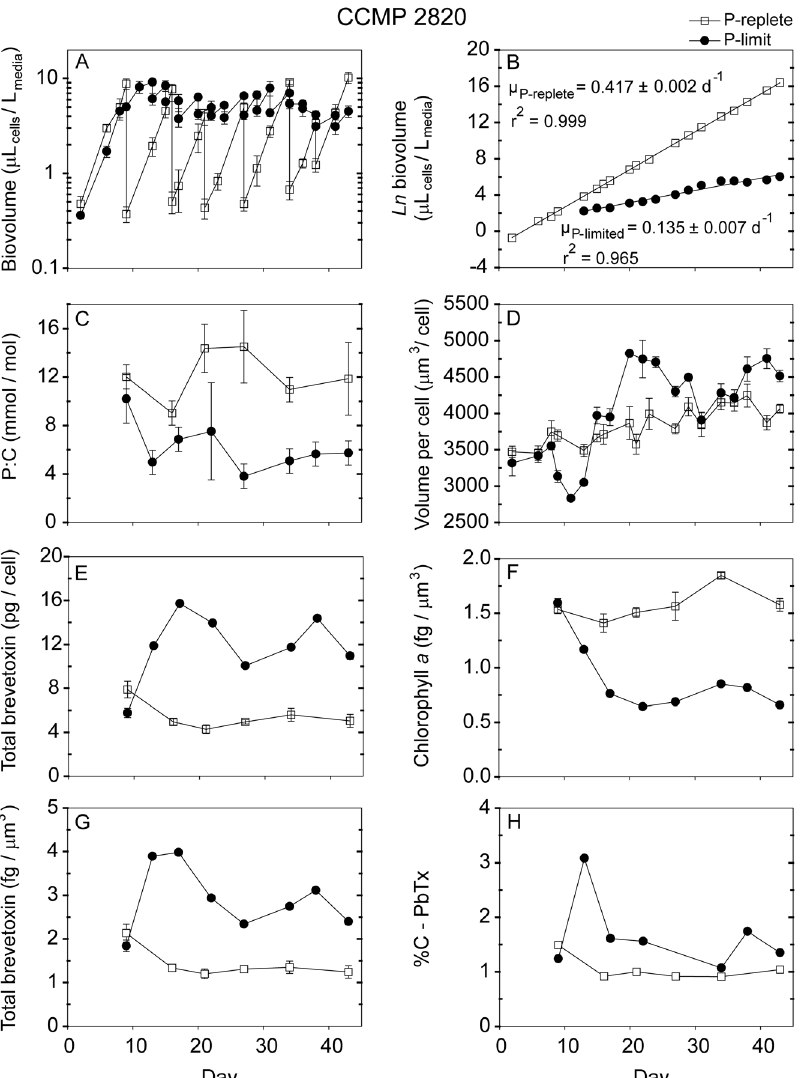
Figure 4. Time dependent results from semi-continuous batch cultures a Kareniabrevis strain CCMP 2820 grown at nutrient-replete rates in high-P media (open squares) and grown into P-limitation in low-P media (filled circles). (A) Biovolume ( m L cells /L media ) plotted on a log scale vs. time, (B) Natural logarithm (ln) biovolume vs. time, correcting for culture dilution [39], (C) Cellular P:C ratios (mmol/mol), (D) Mean volume per cell ( m m 3 /cell), (E) Total brevetoxins per cell (pg/cell), (F) Chlorophyll a normalized to cell volume (fg/ m m 3 ), (G) Total brevetoxins normalized to cell volume (fg/ m m 3 ), (H) Percent of cellular carbon associated with brevetoxins (%C-PbTx). Error bars represent the standard deviation of triplicate measurements, except those normalized to carbon, where the cellular C was measured only in